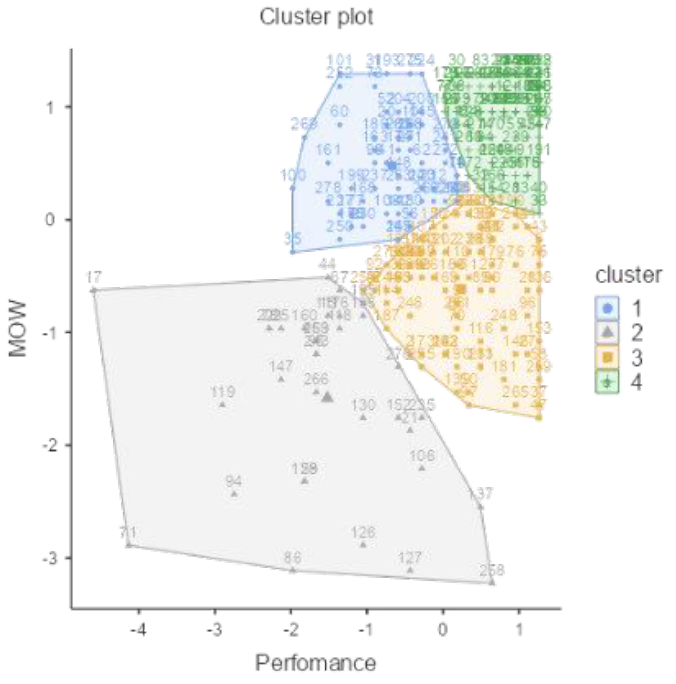
Figure 7. Plot of means across clusters between Meaning of Work and Job Performance. Cluster 1: happy-unproductive; Cluster 2: unhappy-unproductive; Cluster 3: unhappy-productive; Cluster 4: happy-productive. (Study 2; N = 281) (r = 0.39; p < 0.001).